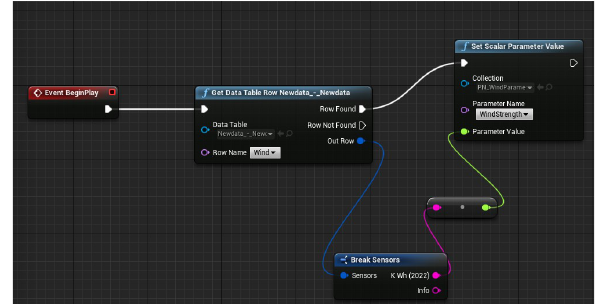
Figure 10. The Event Graph of Blueprint nodes for weather simulation